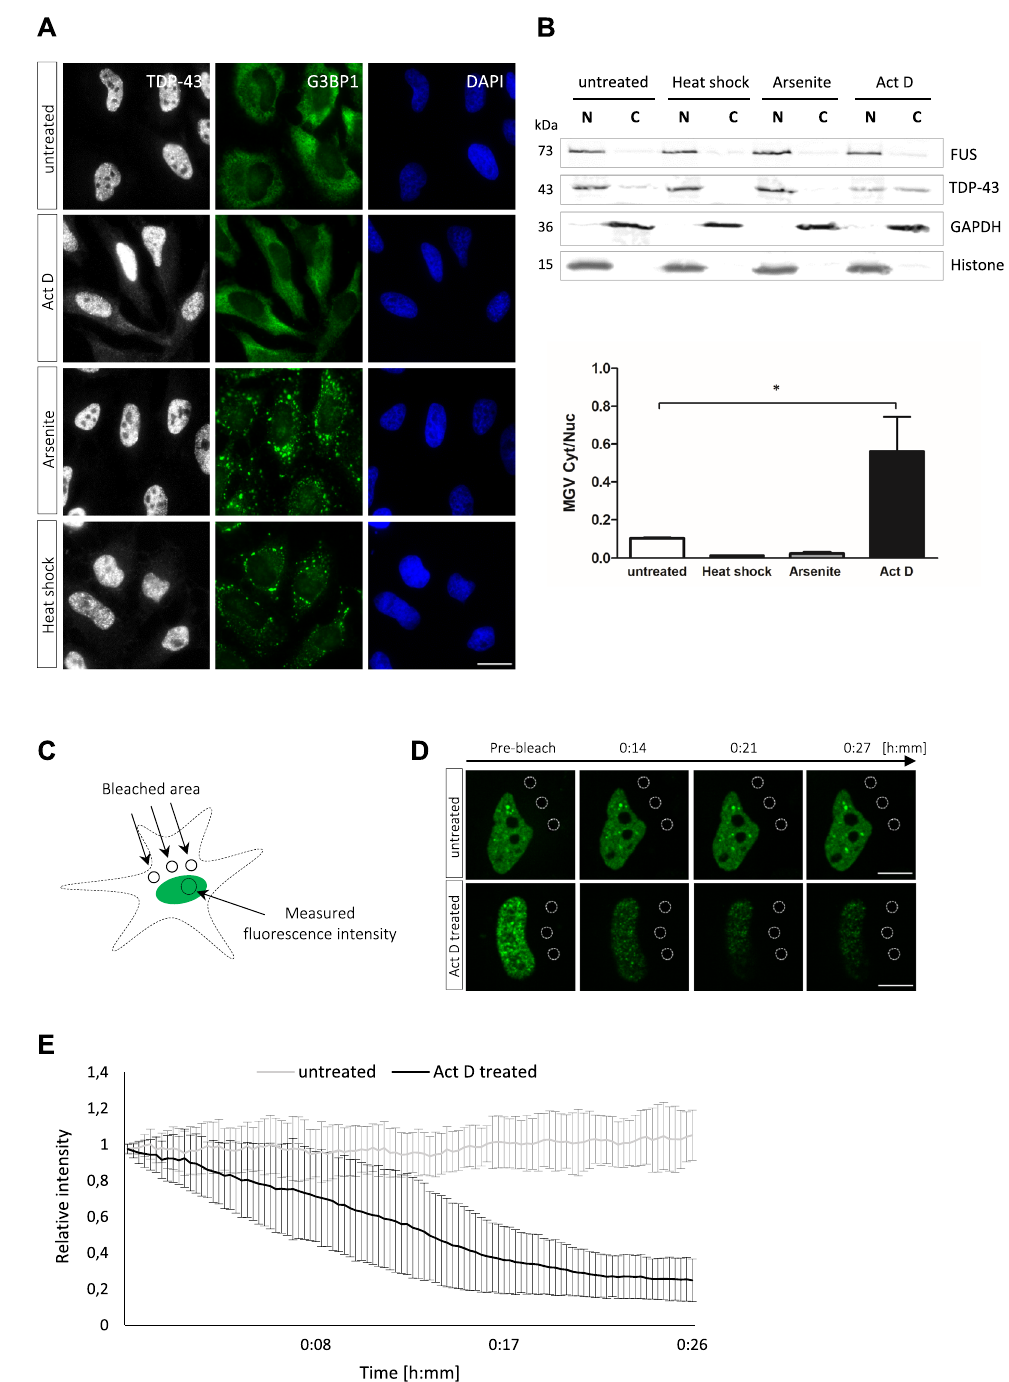
Figure 6. Inhibition of RNA synthesis causes accelerated nuclear egress of TDP-43. ( A ) HeLa cells were either left untreated or treated with Actinomycin D (Act D, 5 µ g/ml for 3 h), arsenite (0.5 mM for 30 min) or heat shock (44 °C for 1 h) and localization of TDP-43 and stress granule formation were examined after immunostaining with antibodies specific for TDP-43 (white), the stress granule marker G3BP1 (green) and DAPI staining (blue). Act D treatment causes a slight relocalization of TDP-43 to the cytoplasm in the absence of stress granule formation. Other stress treatments induce stress granules without inducing TDP-43 relocalization. Scale bar: 20 µ m. ( B ) HeLa cells treated as indicated in A were subjected to hypotonic lysis and separated into a nuclear fraction (N) containing insoluble nuclear proteins and a cytoplasmic fraction ( C ) containing soluble nuclear and cytoplasmic proteins. Fractions were analyzed by SDS-PAGE and immunoblotting with TDP-43- or FUS- specific antibodies. GAPDH served as a cytosolic marker, Histone H3 as a nuclear marker protein. While TDP- 43 is predominantly in the nuclear fraction of untreated, arsenite-treated and heat shocked cells, it is extracted from nuclei into the cytoplasmic fraction after Act D treatment. FUS remains predominantly in the nuclear fraction upon inhibitor treatment. Bar graph shows a quantification of TDP-43 immunoblot signals. Mean